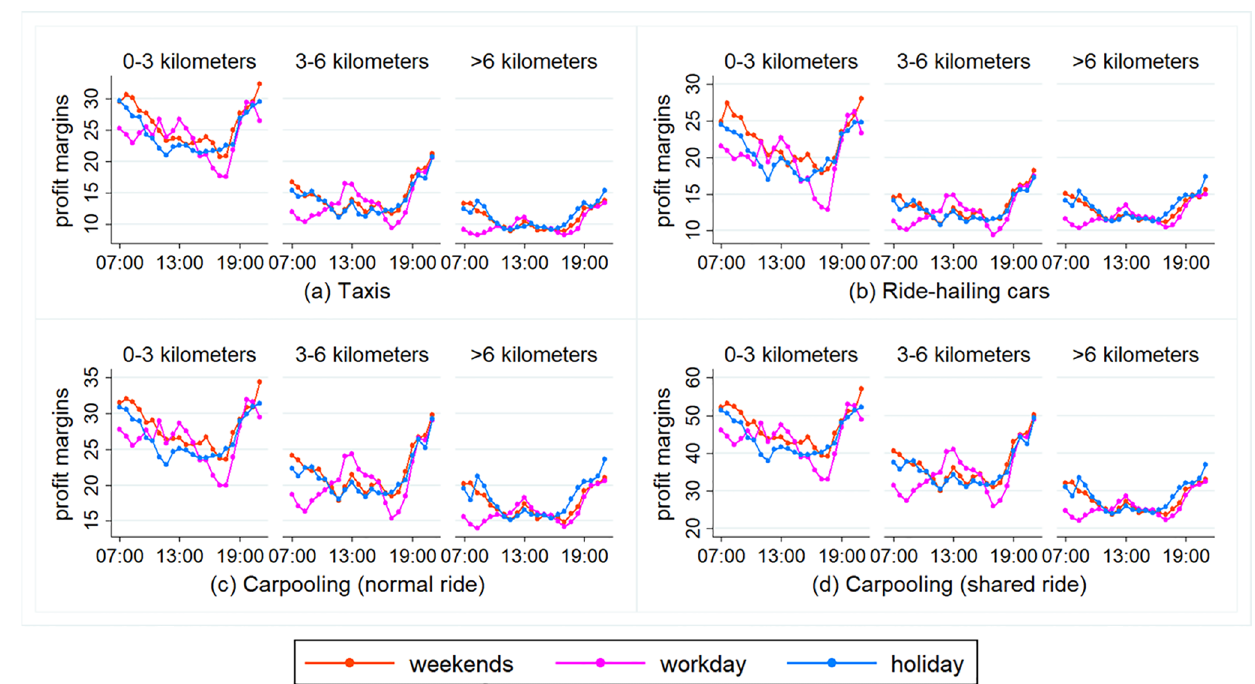
Fig 3. Comparing the profit margins during work days, weekends, and public